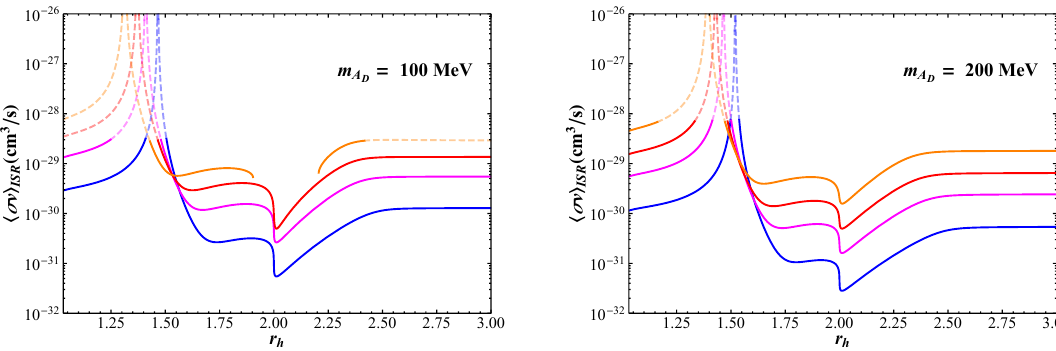
Figure 12. The cross section σv , as discussed in the text, for various benchmark points h i ISR assuming b = 1 and m A = 100 MeV (left) and m A = 200 MeV (right), as a function of r h with r φ D D adjusted to recreate the observed relic abundance. The lines assume that g D = 0 . 3 (Blue), g D = 0 . 5 (Magenta), g D = 0 . 7 (Red), and g D = 1 (Orange). As before, the discontinuity in the g D = 1 curve for m A = 100 MeV arises because near the r h = 2 resonance, there is no value of r φ capable of D reproducing the observed DM abundance for this benchmark. Solid curves indicate that this cross section satisfies the constraints from Planck 2018 [8, 48] and baryon acoustic oscillation [49–51] data on this cross section extracted from [46], while dashed curves indicate that this constraint is violated. Benchmark points for g D = 0 . 1 or m A = 1 GeV are not pictured, because in these D